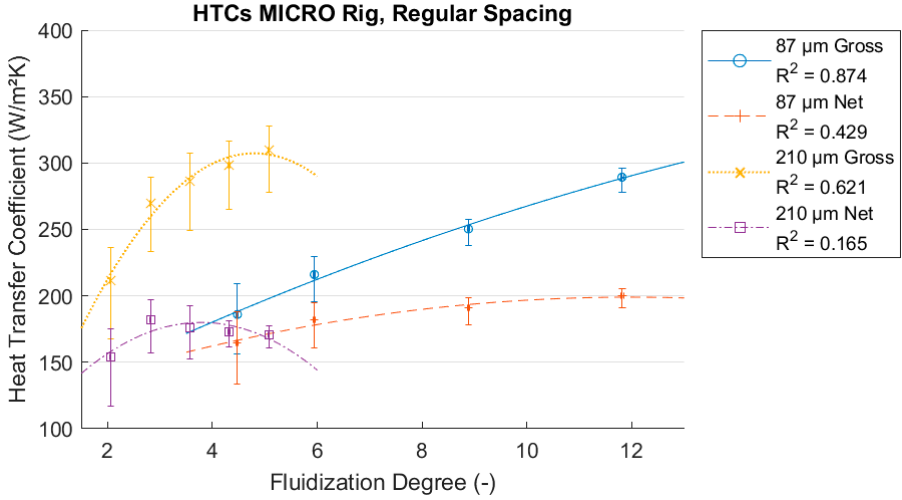
,𝑤 (cid:3040)(cid:3033) (210 µ𝑚) = 43.7 (cid:3040)(cid:3040) , w mf ( 210 µ m ) = 43.7 mm (cid:3046) s